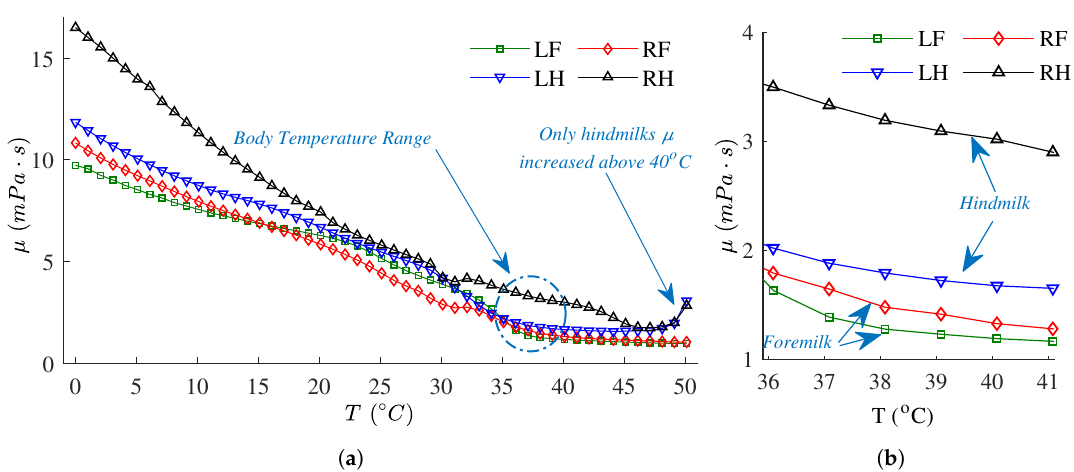
Figure 9. Temperature Sweep Test #1 for samples from Participant #8 at ˙ γ = 50 s − 1 after 5 days refrigeration. ( a ) Temperature decreased viscosity for both foremilk and hindmilk until 45 ◦ C when hindmilk began to increase, ( b ) A closer look over body temperature range shows a steady decrease in viscosity in response to temperature.